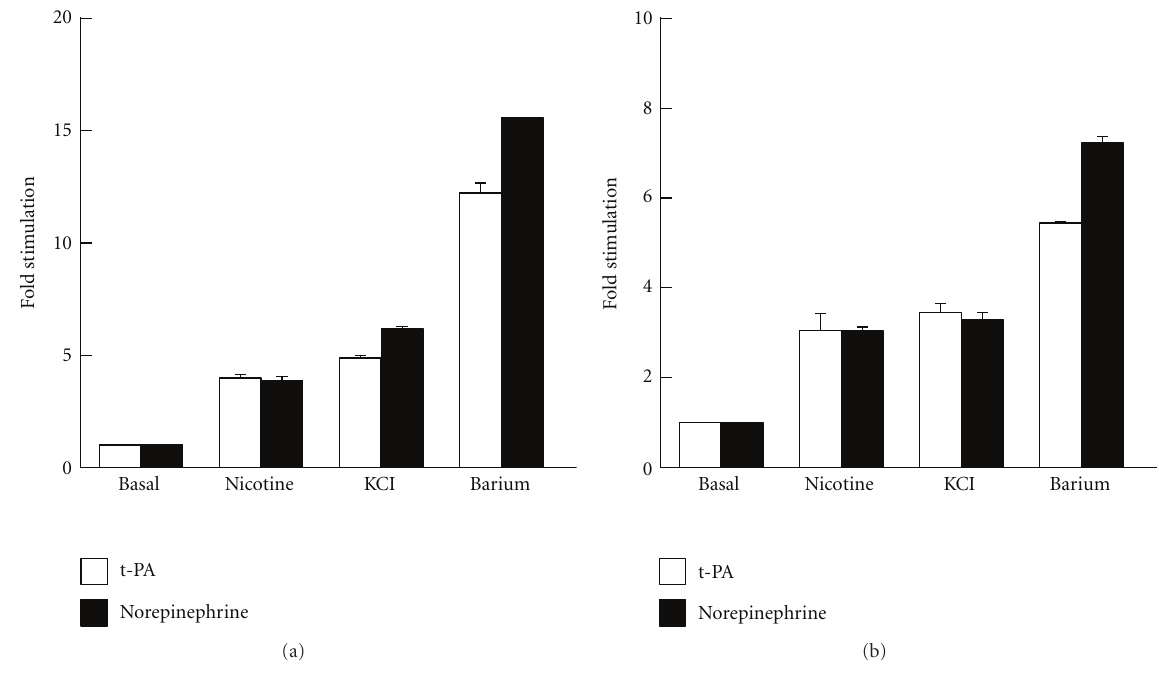
Figure 1: Corelease of t-PA with norepinephrine from catecholaminergic cells. PC12 cells (a) or bovine adrenal chroma ffi n cells (b) were labeled with [ 3 H]-norepinephrine and incubated at 37 ◦ C for 30 min in either the absence or presence of 60 μ M nicotine, 55mMKCl, or 2 mMBaCl 2 . The release bu ff er was aspirated, cells were harvested and lysed, and the release of t-PA antigen (open bars) and [ 3 H]- norepinephrine (filled bars) was determined. [7]. ©The American Society for Biochemistry and Molecular